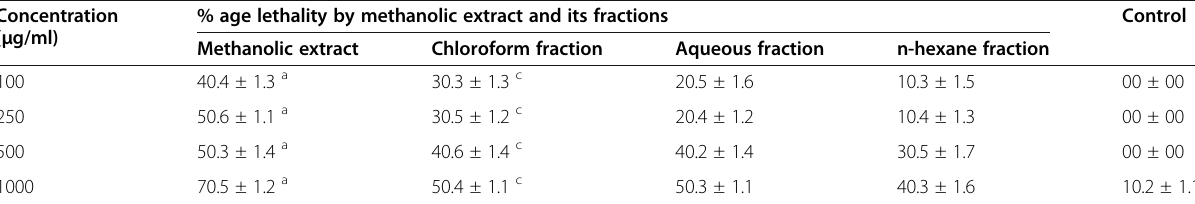
Table 2 Percentage fatality of brine shrimps expressed by methanolic extract and its different fraction of rhizome of Sorghum halepense (L.) Pers Concentration ( μ